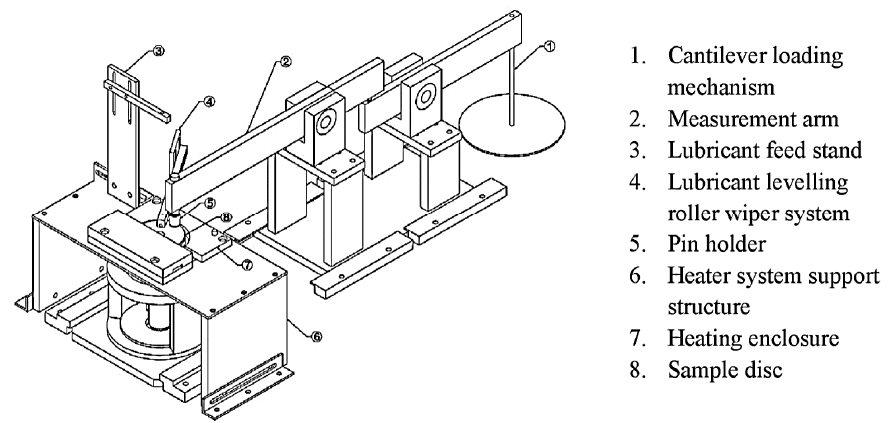
Figure 8. Pin-on-disc tribometer.